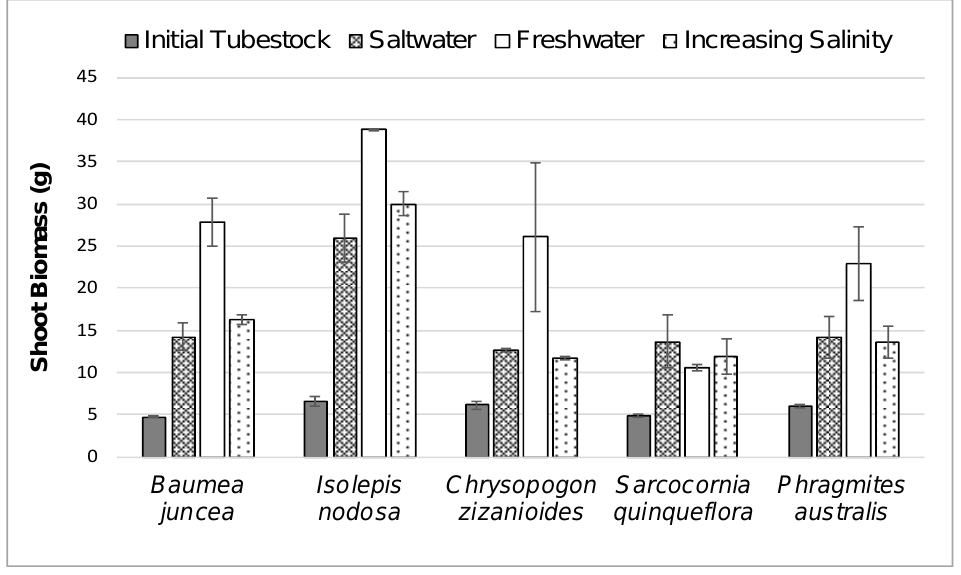
Figure 4. Average Initial and Final Shoot Biomass for Each Species in Each Water Treatment.